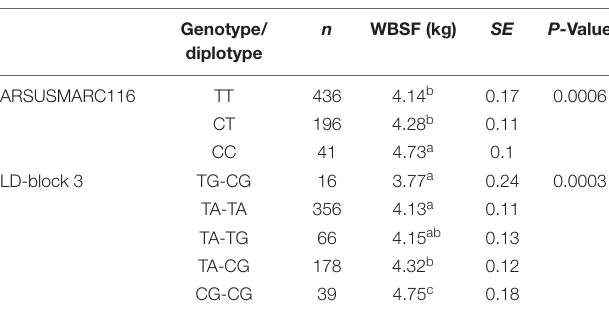
TABLE 3 | Significant effects of one SNP and one LD-block in calpastatin gene on WBSF of Longissimus dorsi muscle in an Angus–Brahman crossbred